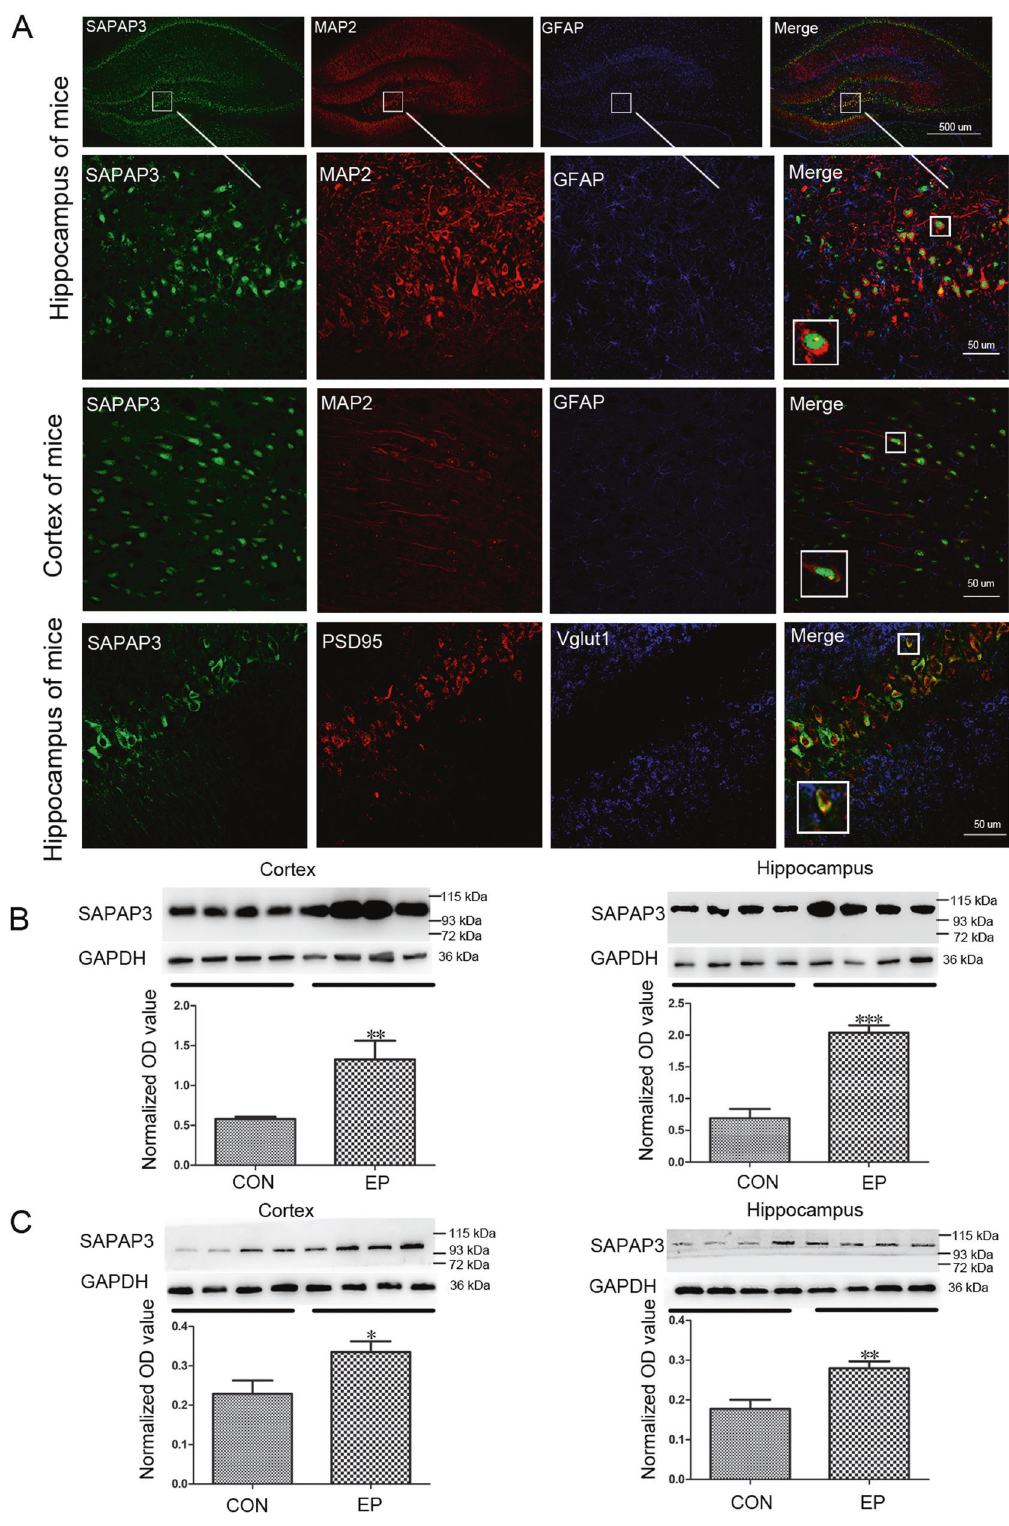
Fig. 2 SAPAP3 expression in the hippocampus and cortex of the mouse model. A Triple-label immuno fl uorescence showed that SAPAP3 (green) and GFAP (blue) were not coexpressed in astrocytes, but SAPAP3 (green) and MAP2 (red) were mainly coexpressed within mouse hippocampal (upper panel) and cortical neurons (middle panel). Triple-label immuno fl uorescence showed that SAPAP3 (green) and VGLUT1 (blue) were not coexpressed, but SAPAP3 (green) and PSD95 (red) were coexpressed (lower panel). B Representative western blot images and quanti fi cation of SAPAP3 expression showed a signi fi cant increase in SAPAP3 expression in the pilocarpine-induced mouse epilepsy model compared with controls (left panel, cortex; right panel, hippocampus). C Representative western blot images and quanti fi cation of SAPAP3 expression showed a signi fi cant increase in SAPAP3 expression in the PTZ-induced mouse epilepsy model compared with the controls (left panel, cortex; right panel, hippocampus). Data are presented as means ± SEM, n = 12 per group. * p < 0.05; ** p < 0.01; *** p < 0.001. Cell Death and Disease (2022)